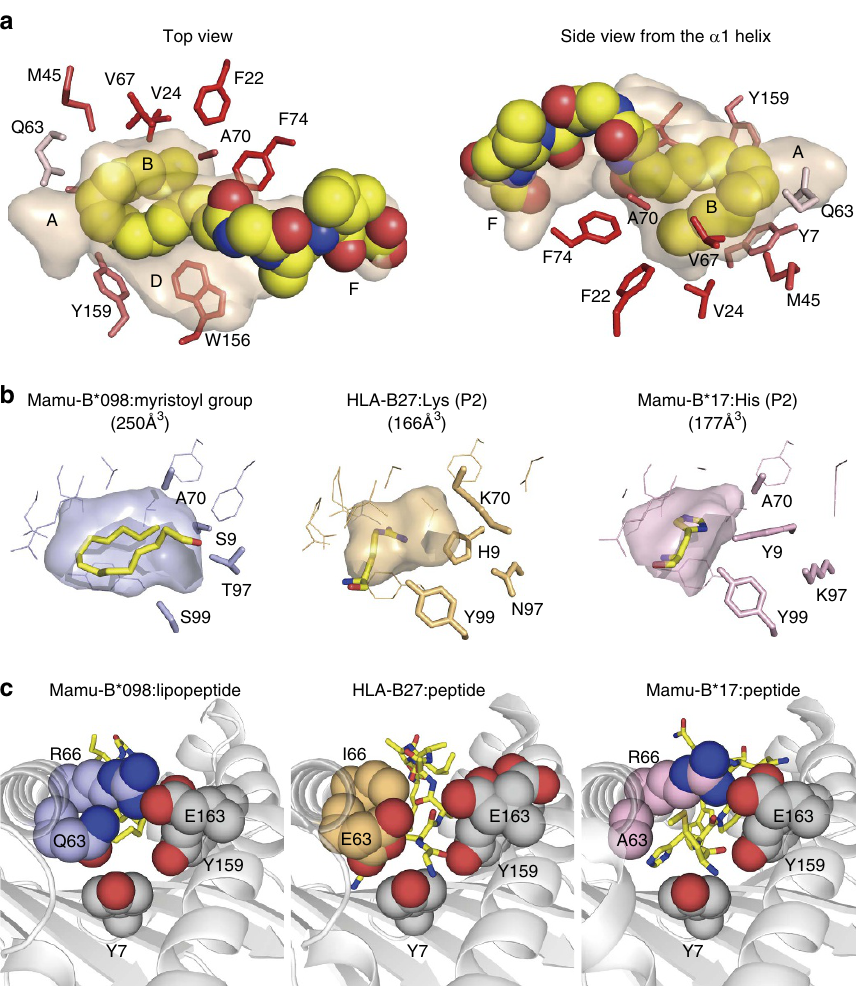
Figure 3 | Interactions with the acyl chain of the lipopeptide. ( a ) C14nef5 is shown in yellow as a space-filling model with the semi-transparent Ag-binding groove of Mamu-B*098. The side chains of residues surrounding the acyl chain are shown in red. The intensity of the red colour correlates with the degree of hydrophobicity. ( b ) B pockets of Mamu-B*098 (blue), HLA-B27 (light orange) and Mamu-B*17 (pink) are shown as the semi-transparent groove and the side chains (lines) with emphasis on the non-bulky side chains (Ser9, Ala70, Thr97 and Ser99) of Mamu-B*098. C14 acyl chain or amino acid residues accommodated in each B pocket are displayed as yellow sticks. ( c ) A view from the A pocket points to a narrower channel between the A and B pockets in Mamu-B*098 (left) than in HLA-B27 (middle) and Mamu-B*17 (right). Key residues are presented as a space-filling